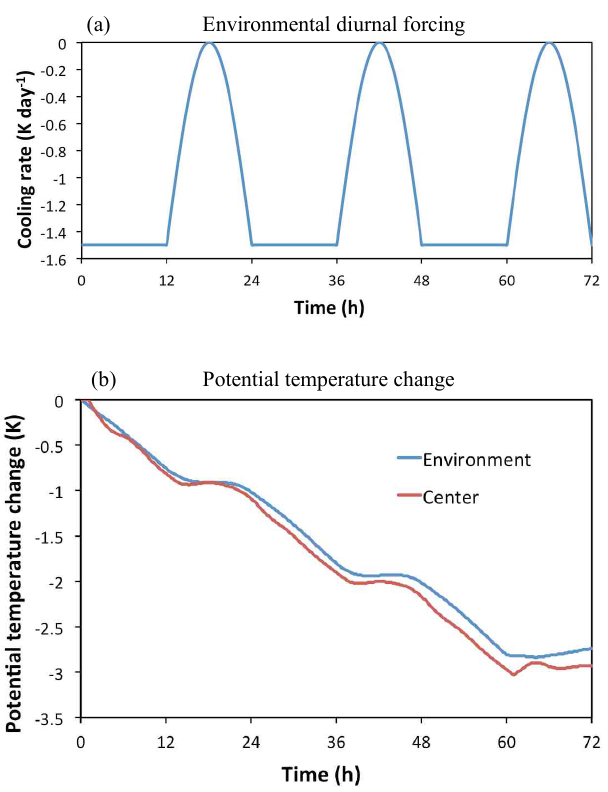
Figure 8. Time series for Experiment 7: the idealized diurnal forc- ing case. (a) Environmental forcing for r > 200km, z < 10km, and (b) potential temperature change in the environment at r = 660km and z = 5km, and at the center of the unforced region at z = 5km.